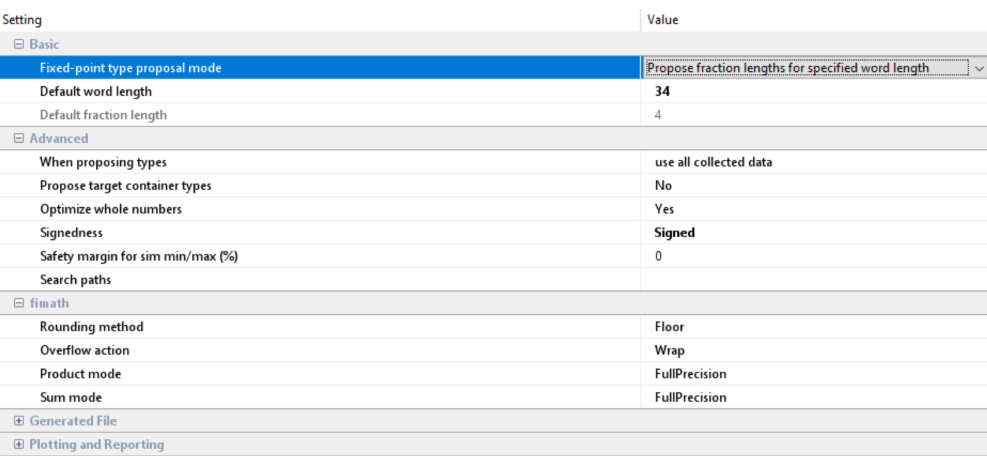
Figure 17. Fixed-Point Converter Sample Configuration.